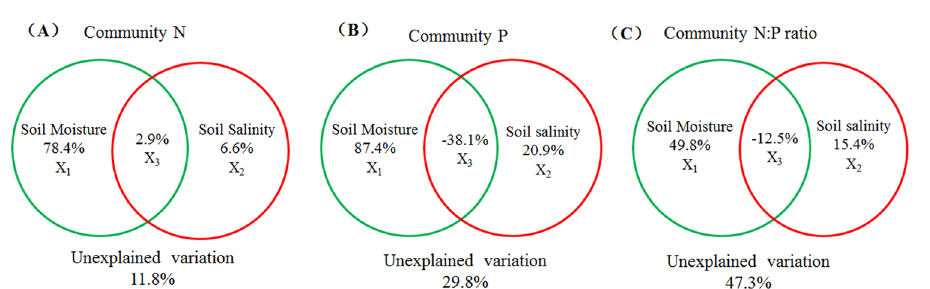
Figure 8. The results of variation-partitioning analysis for species and community N, P and N:P ratio. Variation-partitioning analysis led to the following four fractions: single effect of soil moisture (X1), single effect of soil salinity (X2), joint effects of soil moisture and salinity (X3), and unexplained